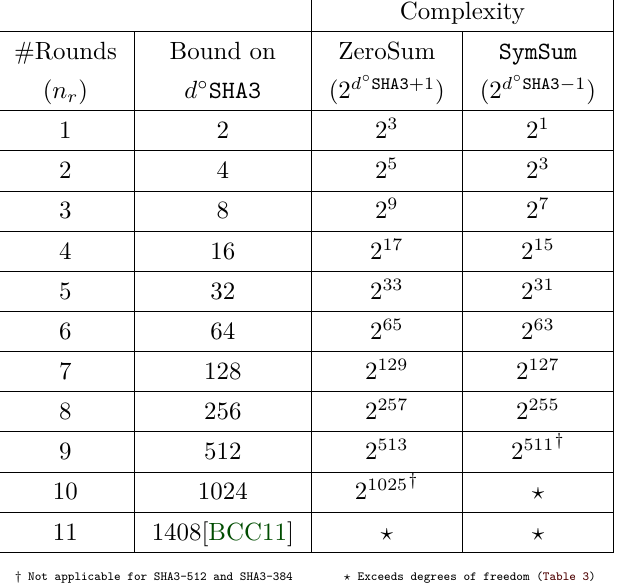
Table 4: Complexity of classical ZeroSum Vs SymSum